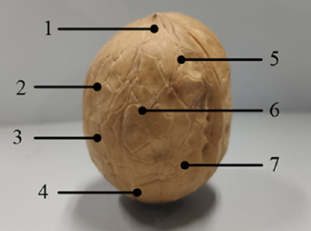
Figure 2. Schematic diagram thickness measurement points of the walnut shell. 1–7 are seven thickness measurement points.